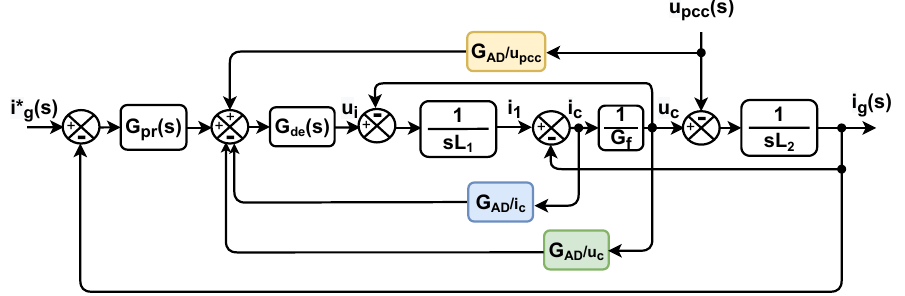
Figure 21. Control block diagram of different state–feedback–based damping